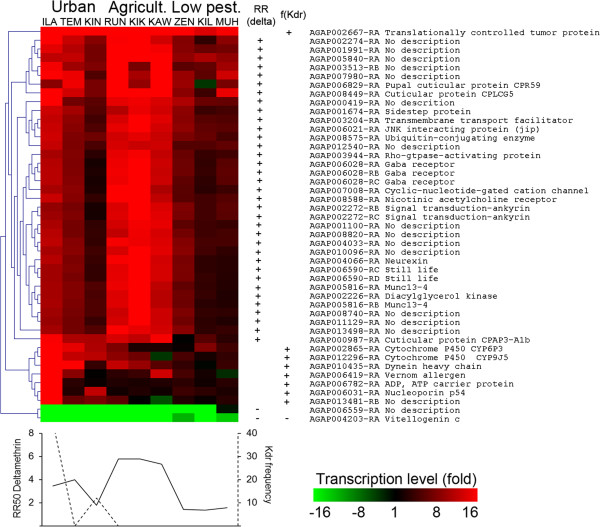
Genes with expression profiles associated with deltamethrin resistance. Clustering analysis was performed on the 46 transcripts showing a correlation between their expression profile and deltamethrin resistance (RR50) and kdr mutation frequency. Clustering of transcripts was based on differences between mean Log2 ratios in each population versus reference using Euclidean distance and complete linkage algorithm. Colour scale (green to red) indicates fold change versus reference strain. + and - indicate a positive (r > 0.85) or negative (r < -0.85) correlation with deltamethrin resistance or kdr mutation frequency.